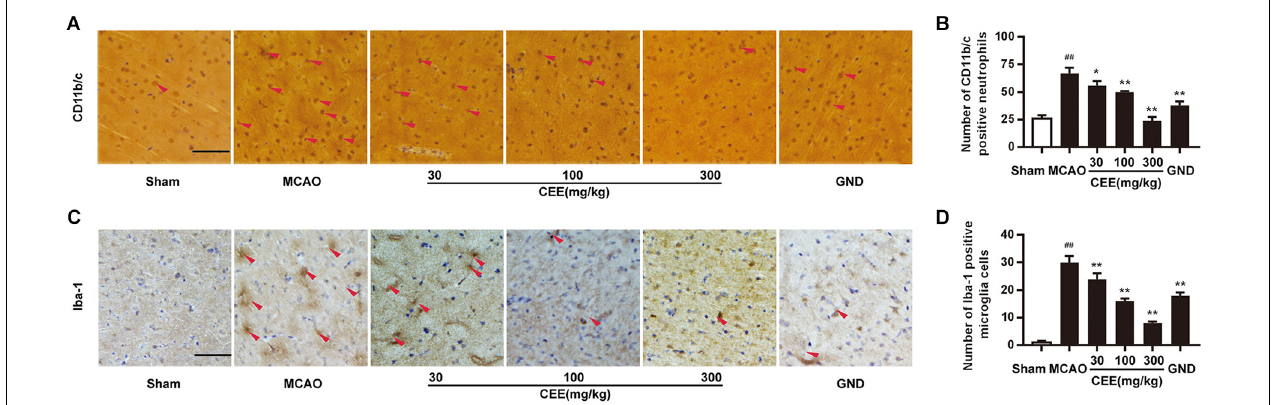
FIGURE 3 | Caesalpinia sappan ethanolic extract inhibits neutrophil and microglial activation in MCAO rats. (A) CD11b/c expression in brains as detected by immunohistochemical staining assay using a specific antibody for CD11b/c (scale bar: 50 µ m). (B) Quantitative assessment of CD11b/c positive neutrophils in rat brain cortex penumbra per field. (C) Iba-1 expression in brains as detected by immunohistochemical staining assay using a specific antibody for Iba-1 (scale bar: 50 µ m). (D) Quantitative assessment of Iba-1 positive microglial cells in rat brain cortex penumbra per field. Three rats in each group and three slices for each rat were examined for IHC assay. Data are expressed as mean ± SD . ## P < 0.01 vs. sham group, ∗∗ P < 0.01, ∗ P < 0.05 vs. MCAO